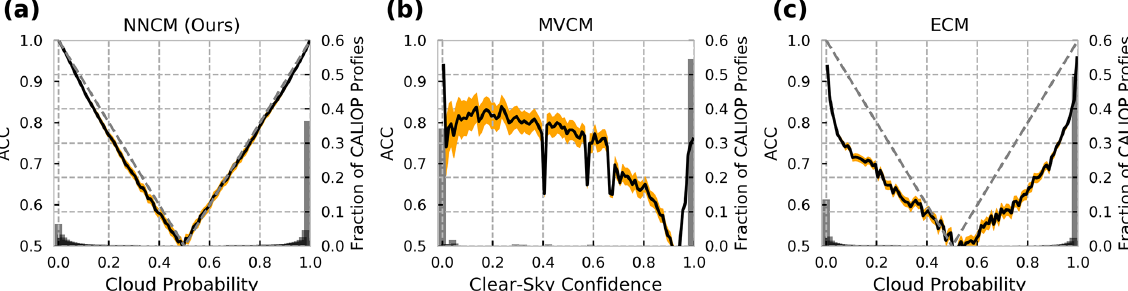
Figure 11. Uncertainty assessments for (a) the NNCM, (b) the MVCM, and (c) the ECM. ACC values (left y axis) for cloud probability and clear-sky confidence values are calculated for bins of size 0.01. For (a) and (c) a perfectly calibrated model is plotted with the dashed gray line (see main text). Orange shading indicates the 99.9% confidence interval. Gray bars indicate the fraction of collocations falling within each bin of width 0.01.